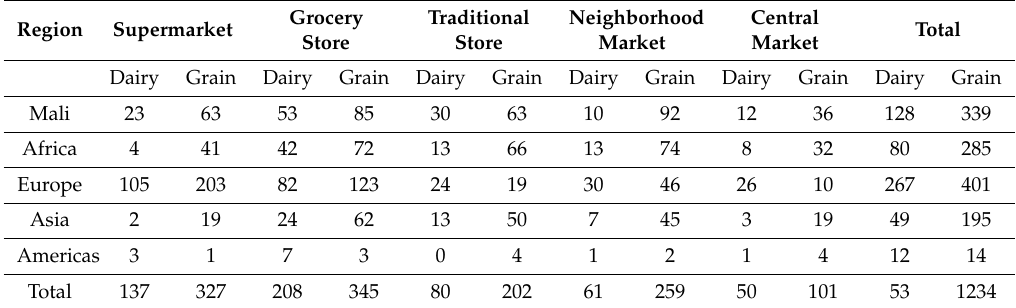
Table 3. Region of manufacturing of processed grain and dairy products by retail outlet (# of products) (Source: Inventory dataset (2016), as computed by the authors. A t-test indicates that the share of products from Europe is significantly higher in supermarkets than any other retail outlets at the 1% level of significance. The country of origin was missing for seven